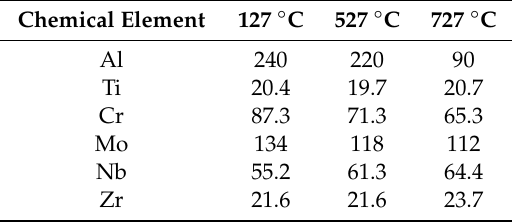
Table 2. Coe ffi cients of thermal conductivity of metals depending on temperature, W⁄(m × K) [77]. Chemical